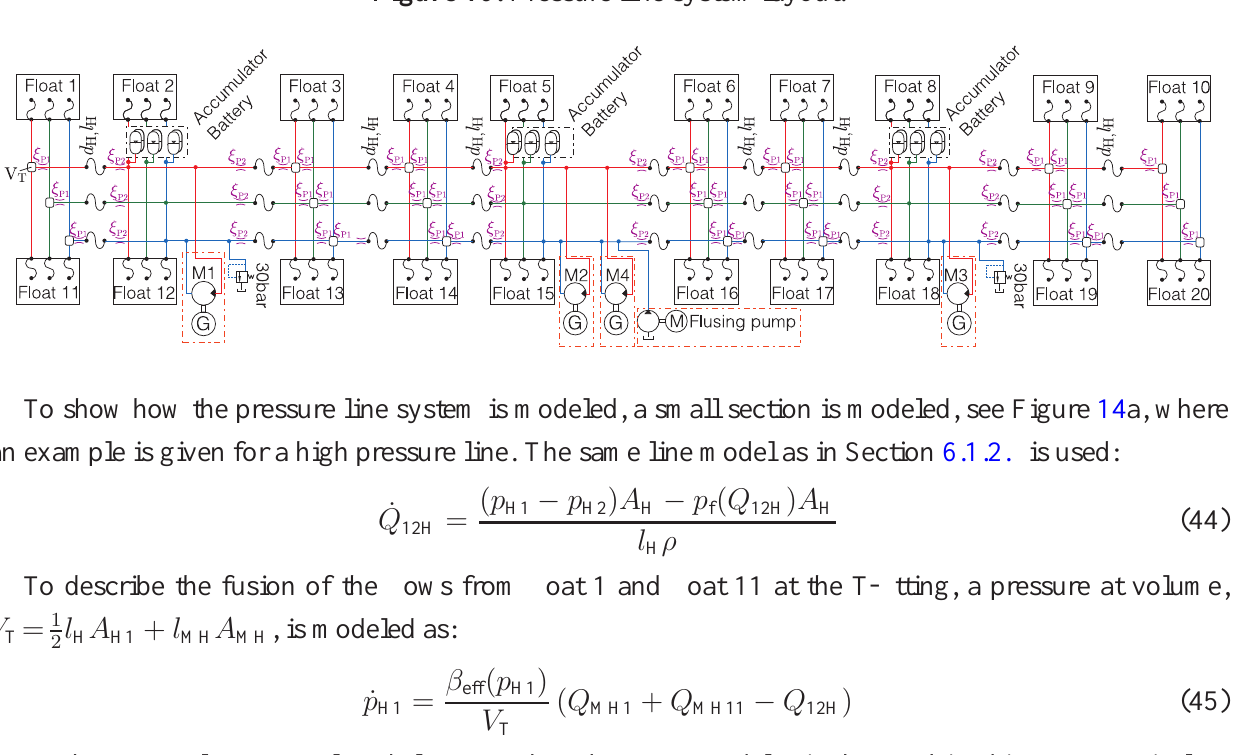
Figure 16. Pressure line system layout.